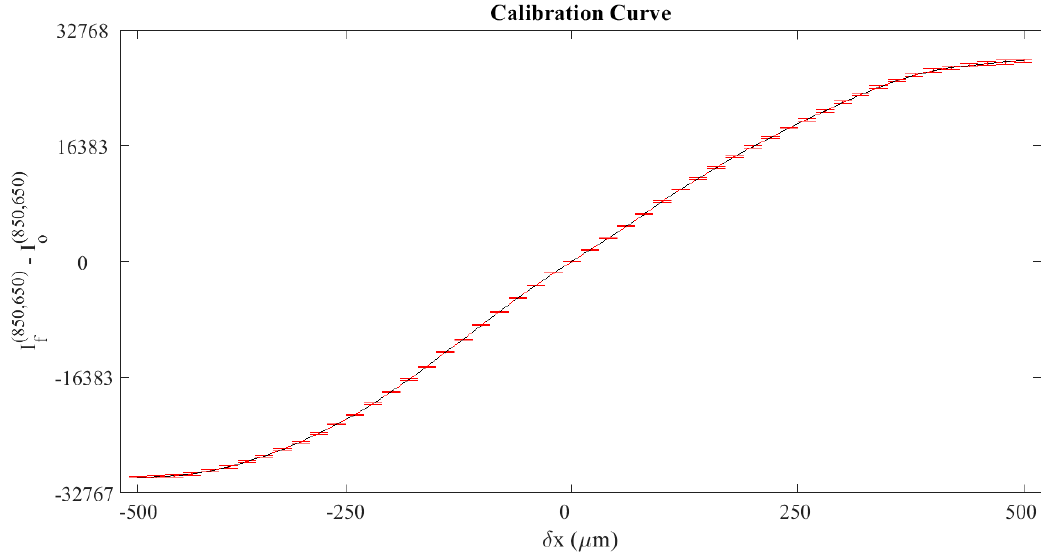
Figure 4. A typical calibration curve of a pixel and deviation along the curve.